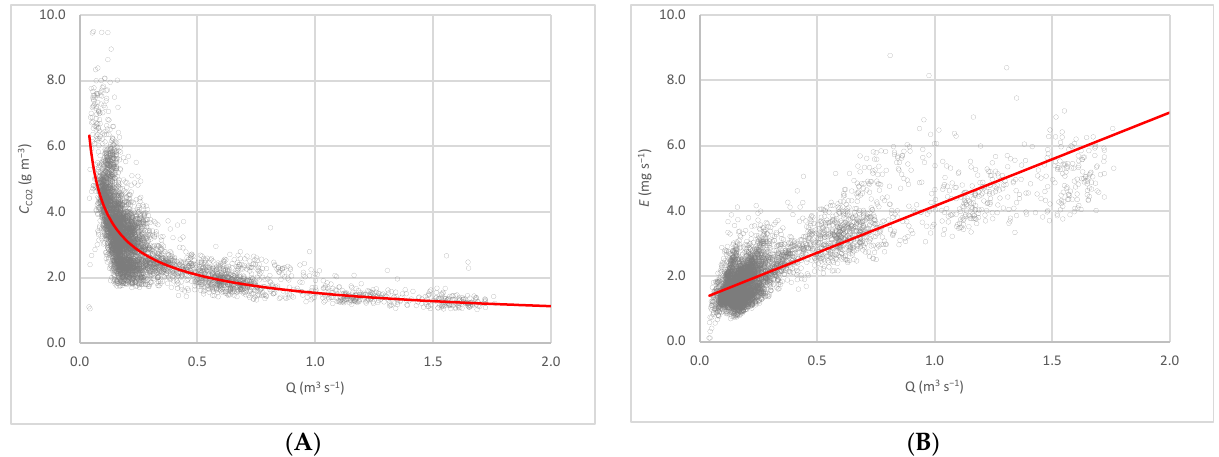
Figure 4. Evolution of ventilation flow, – Q (m 3 s − 1 ) during the cycle, with (A) concentration of CO 2 , – C CO2 (g m − 3 ), and (B) emission of CO 2 per animal, – E CO2 (mg s − 1 ).